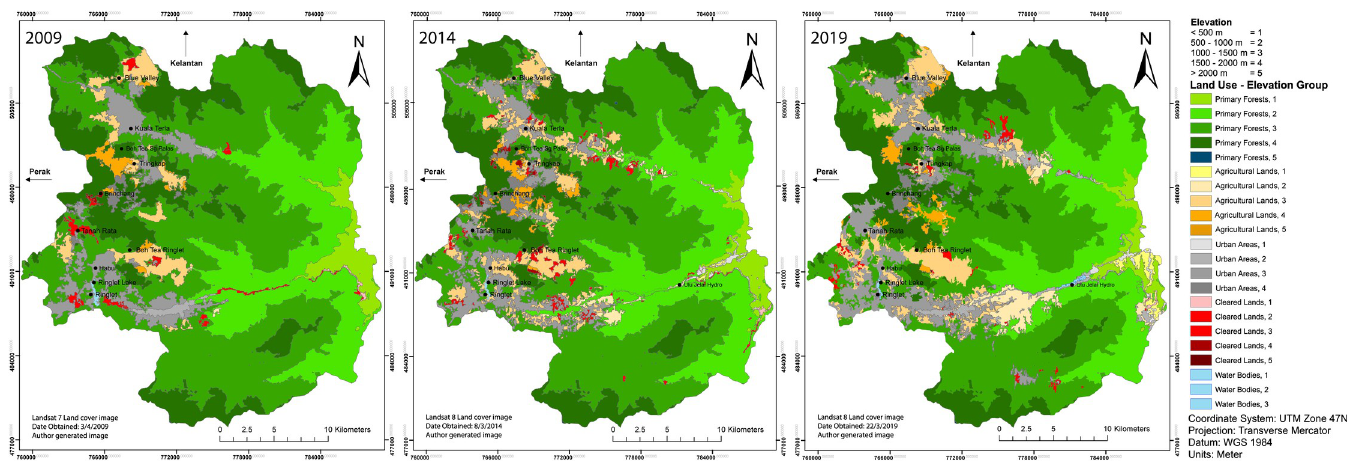
Fig 4. LULCC of Cameron Highlands by elevation group between 2009 and 2019. (Data source: Landsat 7 ETM+ and Landsat-8 OLI image courtesy of the U.S. Geological Survey).